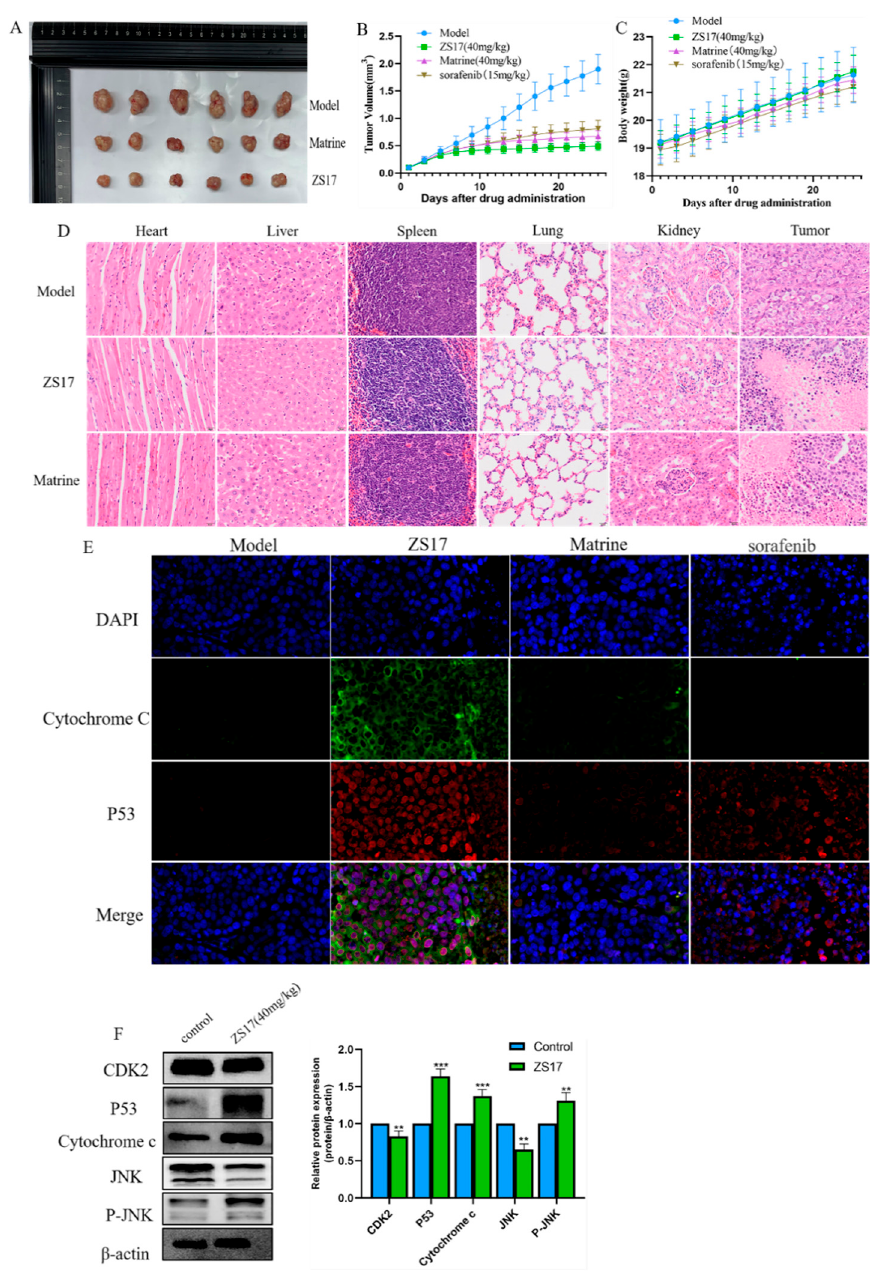
Figure 9. ZS17 inhibited tumor growth in human HepG2 xenograft nude mouse model. ( A , B ) Tumor growth curves and volume in ZS17 -treatment and model groups. ( C ) Body weight curves. ( D ) Histopathological analysis of mouse heart, livers, spleen, lung, kidneys, and tumor by hematoxylin and eosin (H&E) staining. ( E ) IF expression of Cytochrome c and p53 proteins in tumor tissue. ( F ) Western blot assays using lysates of isolated tumors and indicated antibodies. There were six nude mice in each group. Microscope’s magnification is 40×. Data are expressed as mean ± SD. Compared with model group: ** p < 0.01, *** p <